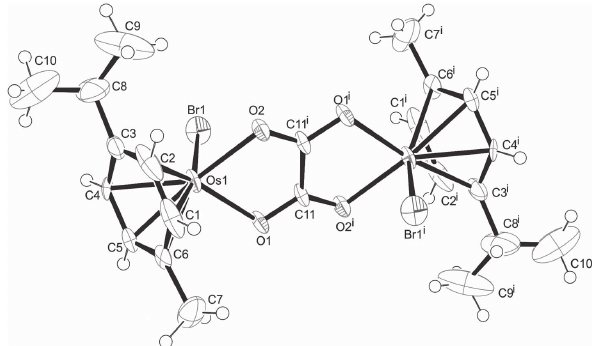
Table 1: Data collection and